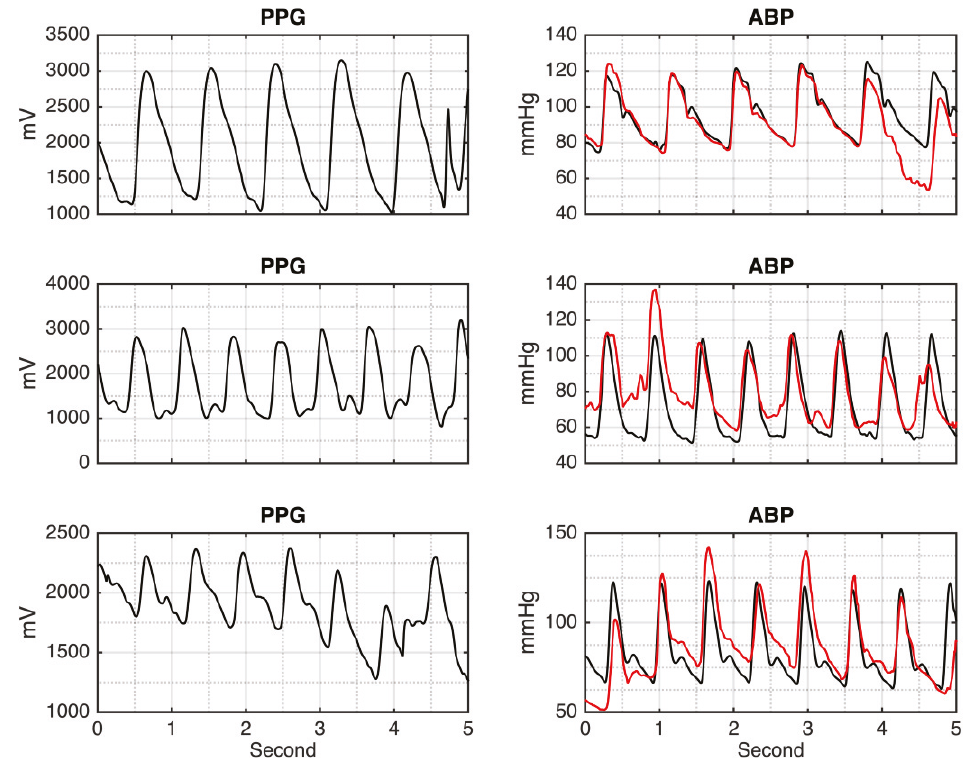
Figure 8. Low-quality generated continuous ABP result.